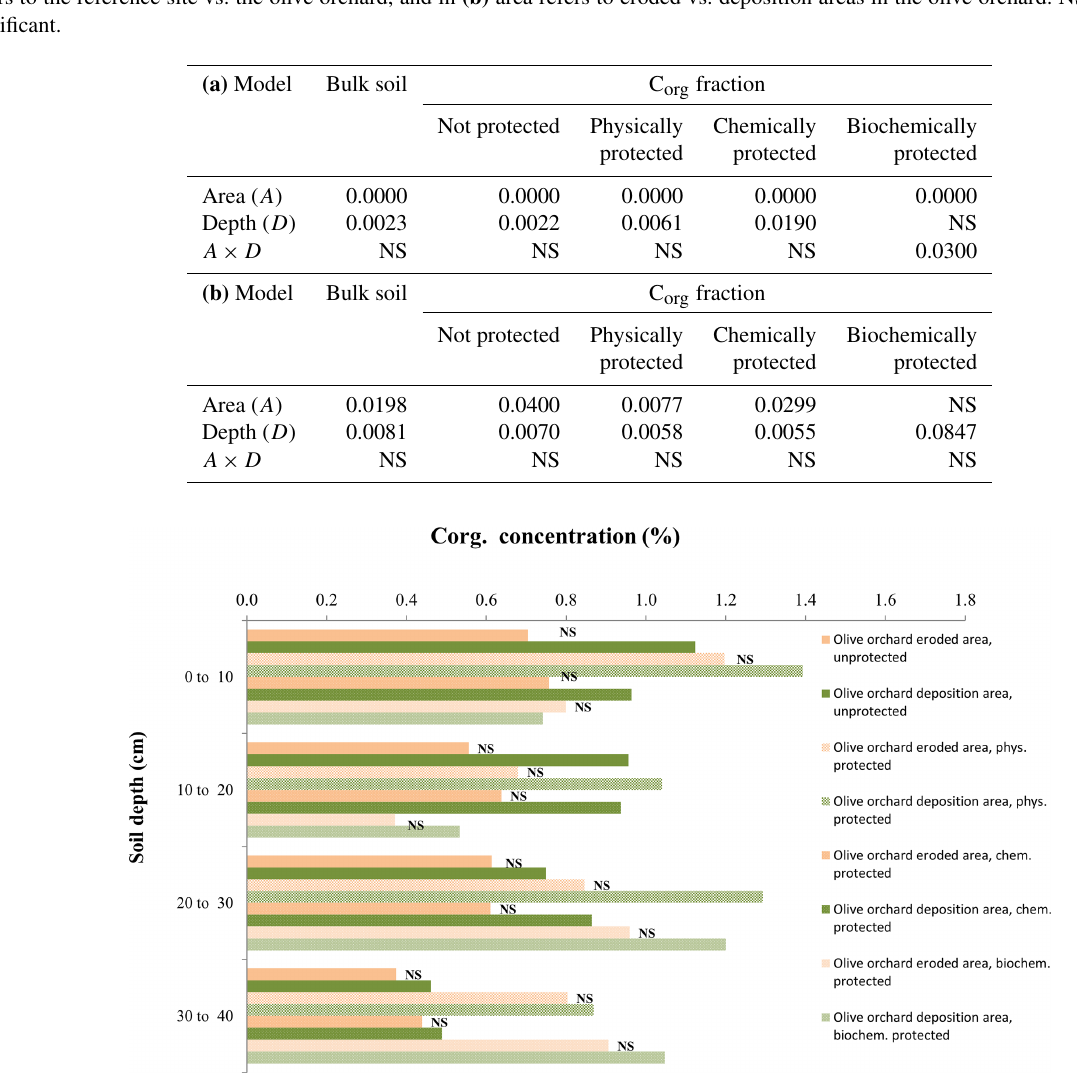
Figure 4. Organic carbon concentration in the different soil organic carbon fractions at each depth, comparing the eroded vs. the deposition area within the olive orchard. The labels of the bars indicate the p value according to a one-way ANOVA comparing treatments for the same soil depth and carbon fraction between the reference area and olive